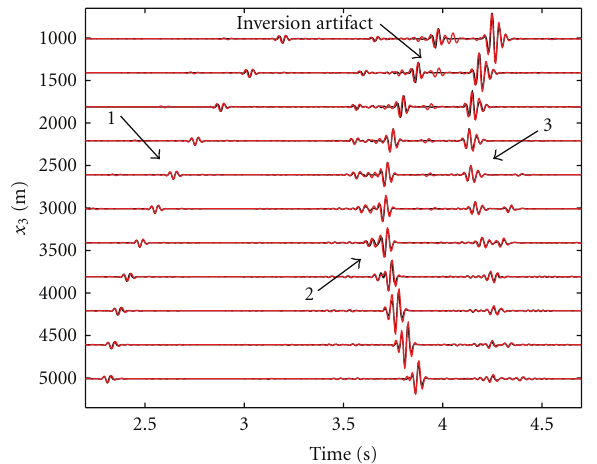
Figure 33: Migrated section of the salt flank from the MDD data in a model with varying source spectra and a gas cloud; the location of the salt flank as taken from the velocity model is given by the red dashed line; markers A–G are discussed in the main